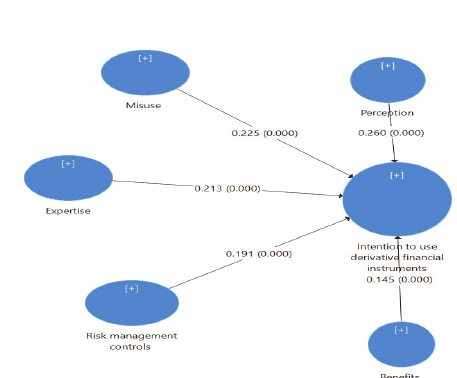
Fig. 8. Results of multi-group analysis with the CEO position